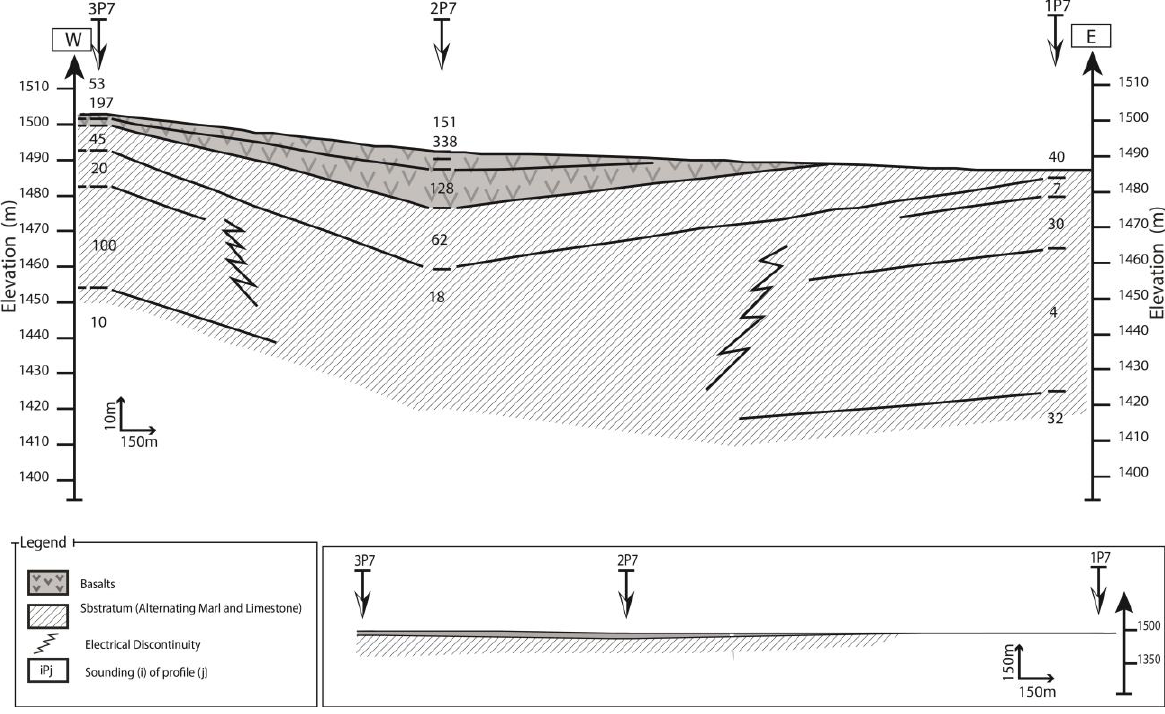
Figure 9. GS4 geoelectrical section of profile 7.